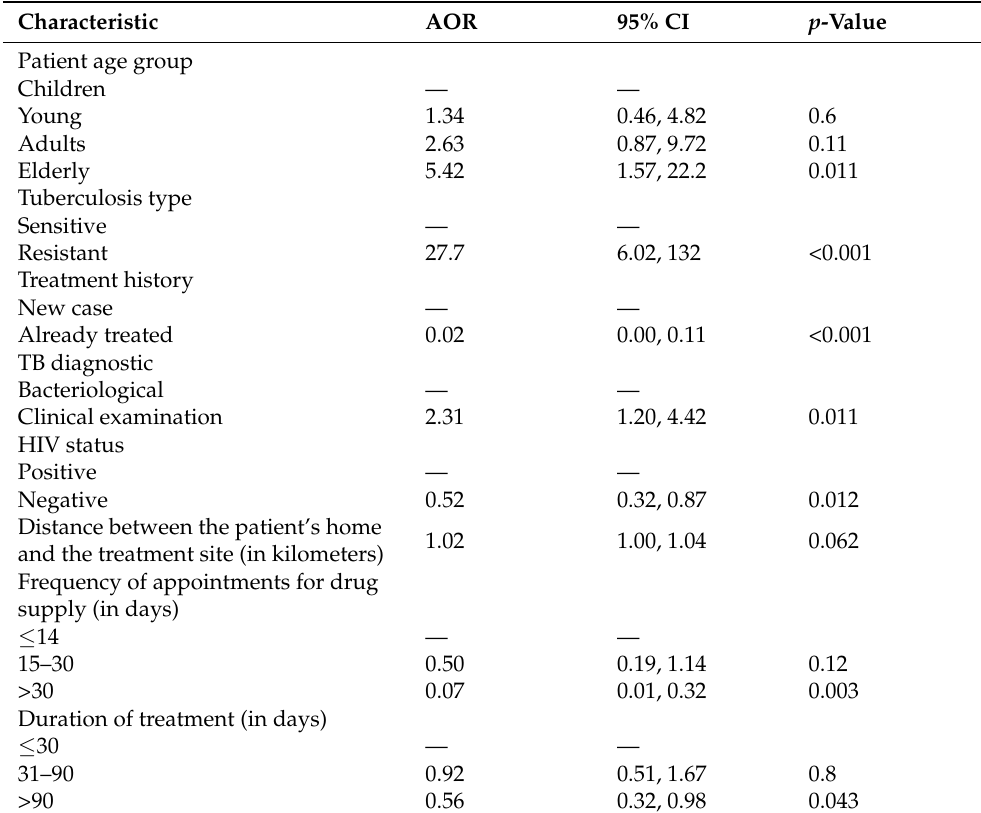
Table 4. Multinomial logistic regression between difficulty with usual activities and sociodemo- graphic and clinical